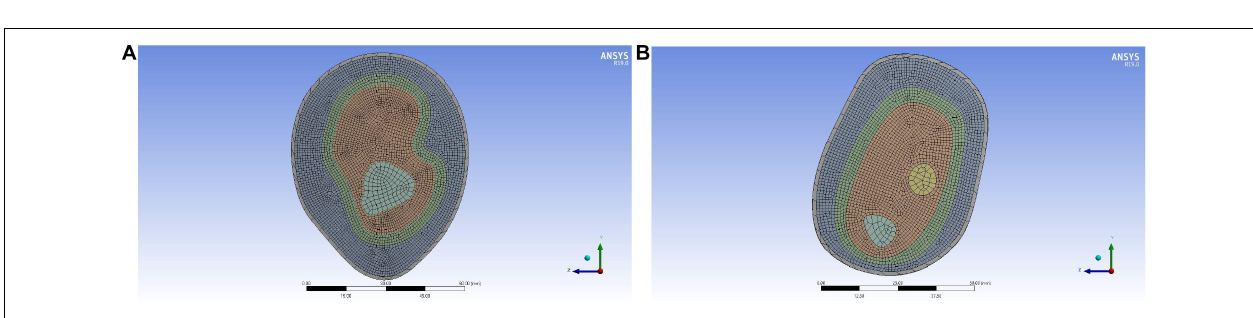
Spectra Magnetic Resonance Imaging System is used as the template to scan the active human upper limb. The middle of the upper arm and the middle of the forearm are used as reference images to simplify and reconstruct the original scanned image. The volunteer for upper limb information collection was a 24 years old urban woman, 165 cm in height and 115 kg in weight.